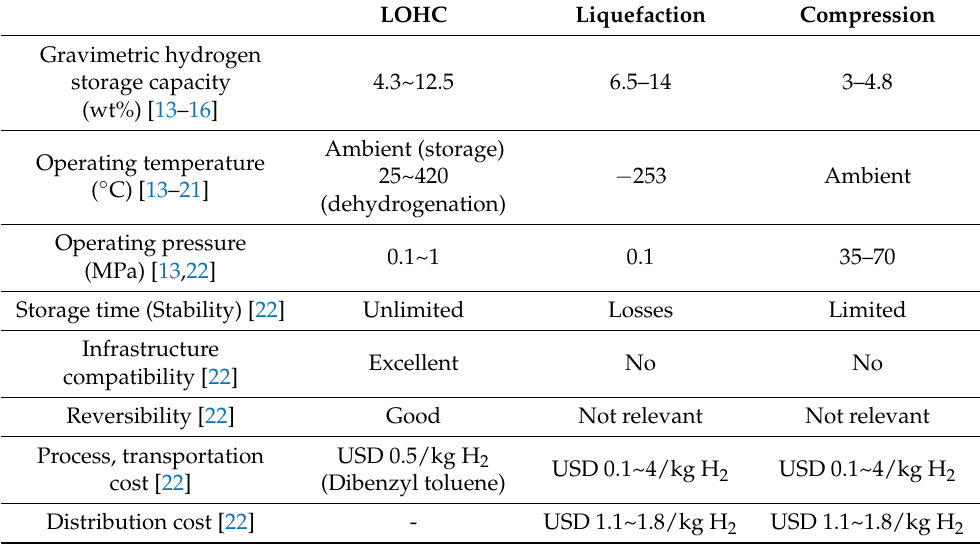
Table 2. Comparison of hydrogen storage